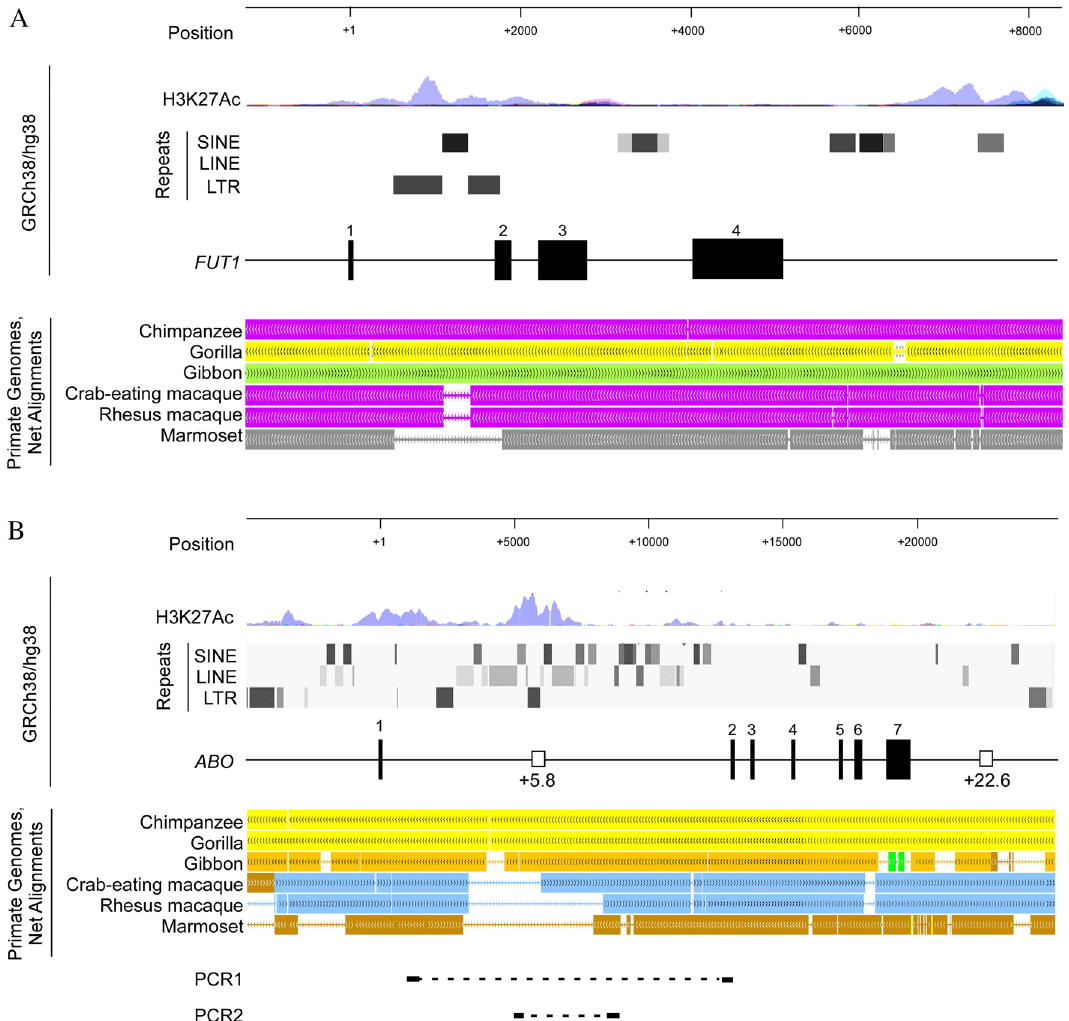
Figure 1. Homology of nucleotide sequences from the upstream to downstream regions of FUT1 or ABO between human and non-human primates. ( A ) Human FUT1 , ( B ) Human ABO . Upper panel shows positions relative to the transcription start site of FUT1 or ABO . The second panel from the top indicates the acetylation at lysine 27 of histone 3 in FUT1 or ABO , often found near active regulatory elements, which was demonstrated by ENCODE Regulation Tracks. The third panel from the top denotes repeating elements including SINE, LINE, and LTR, which were revealed by RepeatMasker over the genomic structure of FUT1 or ABO . The fourth panel shows the genomic structure from the upstream region through FUT1 or ABO to the downstream region, including exons, as well as regulatory regions such as the + 5.8- and + 22.6-sites for erythroid cells and epithelial cells, respectively, on the basis of the human genome draft GRCh38/hg38. Exons are denoted by filled boxes, and the regulatory regions are indicated by empty boxes. The fifth panel shows a comparison of the genome sequences for human with their reference sequences for non-human primates including chimpanzee, gorilla, gibbon, crab-eating macaque, rhesus macaque, and marmoset using Primate Genomes, Chain and Net Alignments 18 . Nucleotides with high identity are highlighted. The bottom panel of ( B ) shows the locations of PCR-amplified fragments of PCR1 and